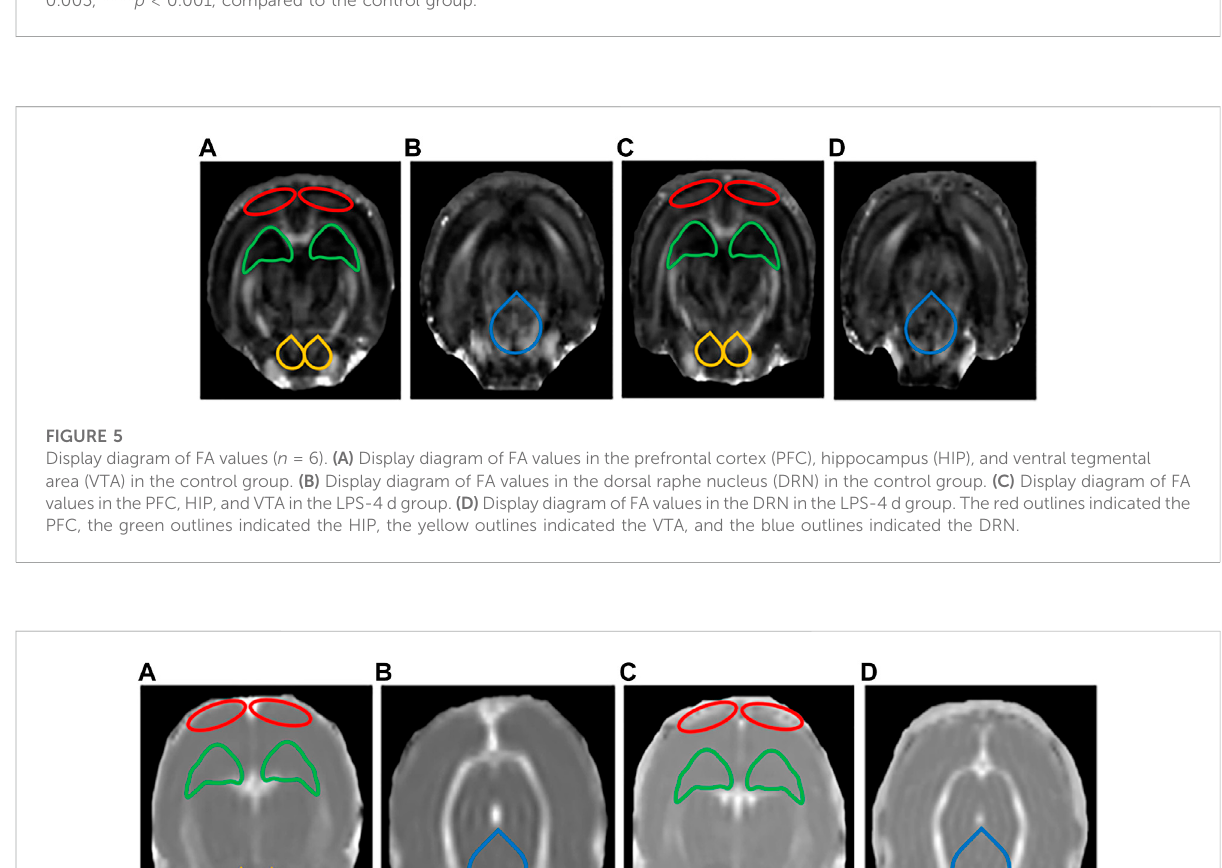
FIGURE 4 Diffusion tensor imaging (DTI) analysis of the bilateral hippocampus (L HIP, R HIP), prefrontal cortex (L PFC, R PFC), ventral tegmental area (L VTA, R VTA), and dorsal raphe nucleus (DRN) in the control group and the LPS-4 d group. (A) Fractional anisotropy (FA) in the control group and the LPS-4dgroup. (B) Meandiffusivity(MD)inthecontrolgroupandtheLPS-4dgroup. Dataareexpressedasthemean±SEM( n =6).** p < 0.01,*** p < 0.005, **** p < 0.001, compared to the control group.